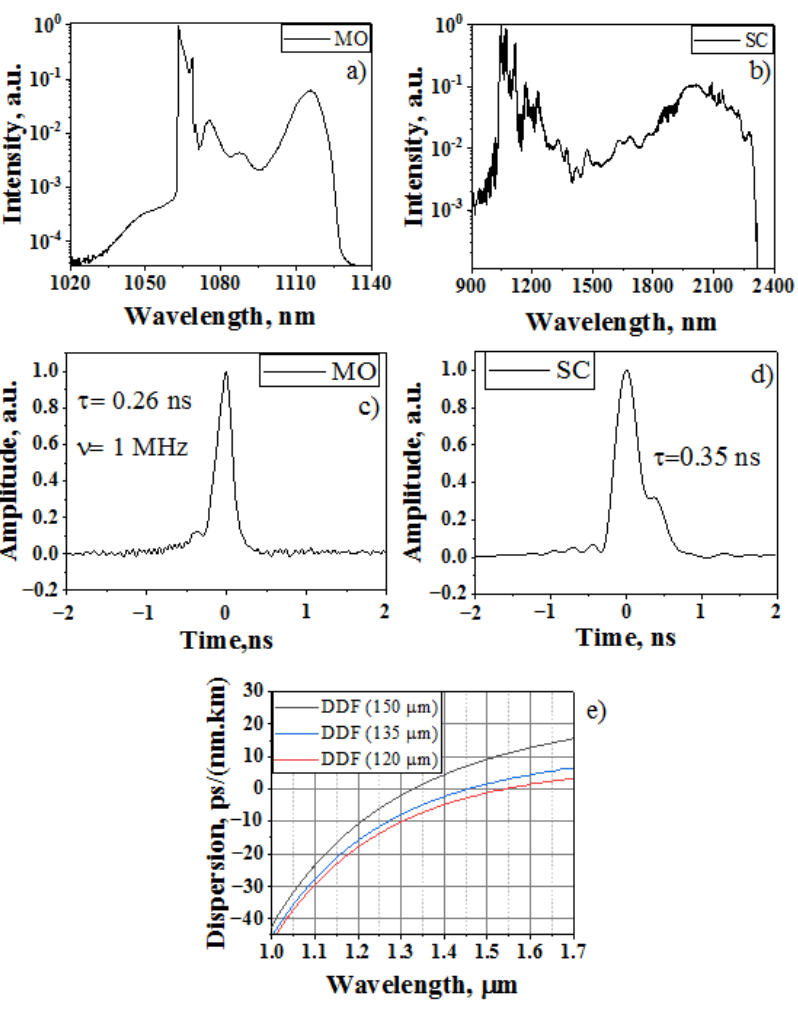
Figure 2. Spectral ( a , b ) and temporal ( c , d ) characteristics of MO (left column) and SC (right column), and ( e ) dispersion plot for DDF.